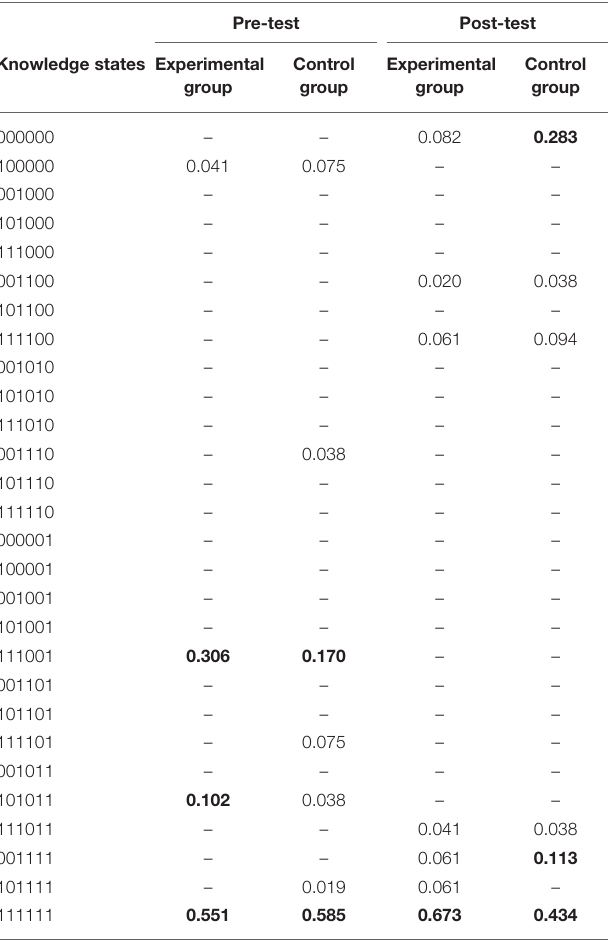
TABLE 9 | The probability of students belonging to each possible knowledge state in both conditions and